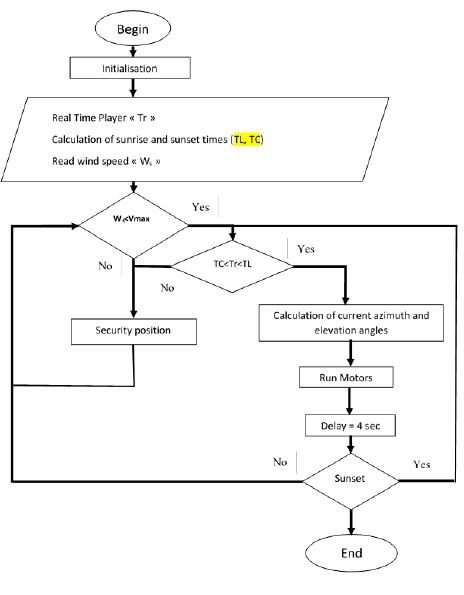
Fig. 3. Flowchart of the heliostat control Table 1. Stepping Sequence of Wave Drive